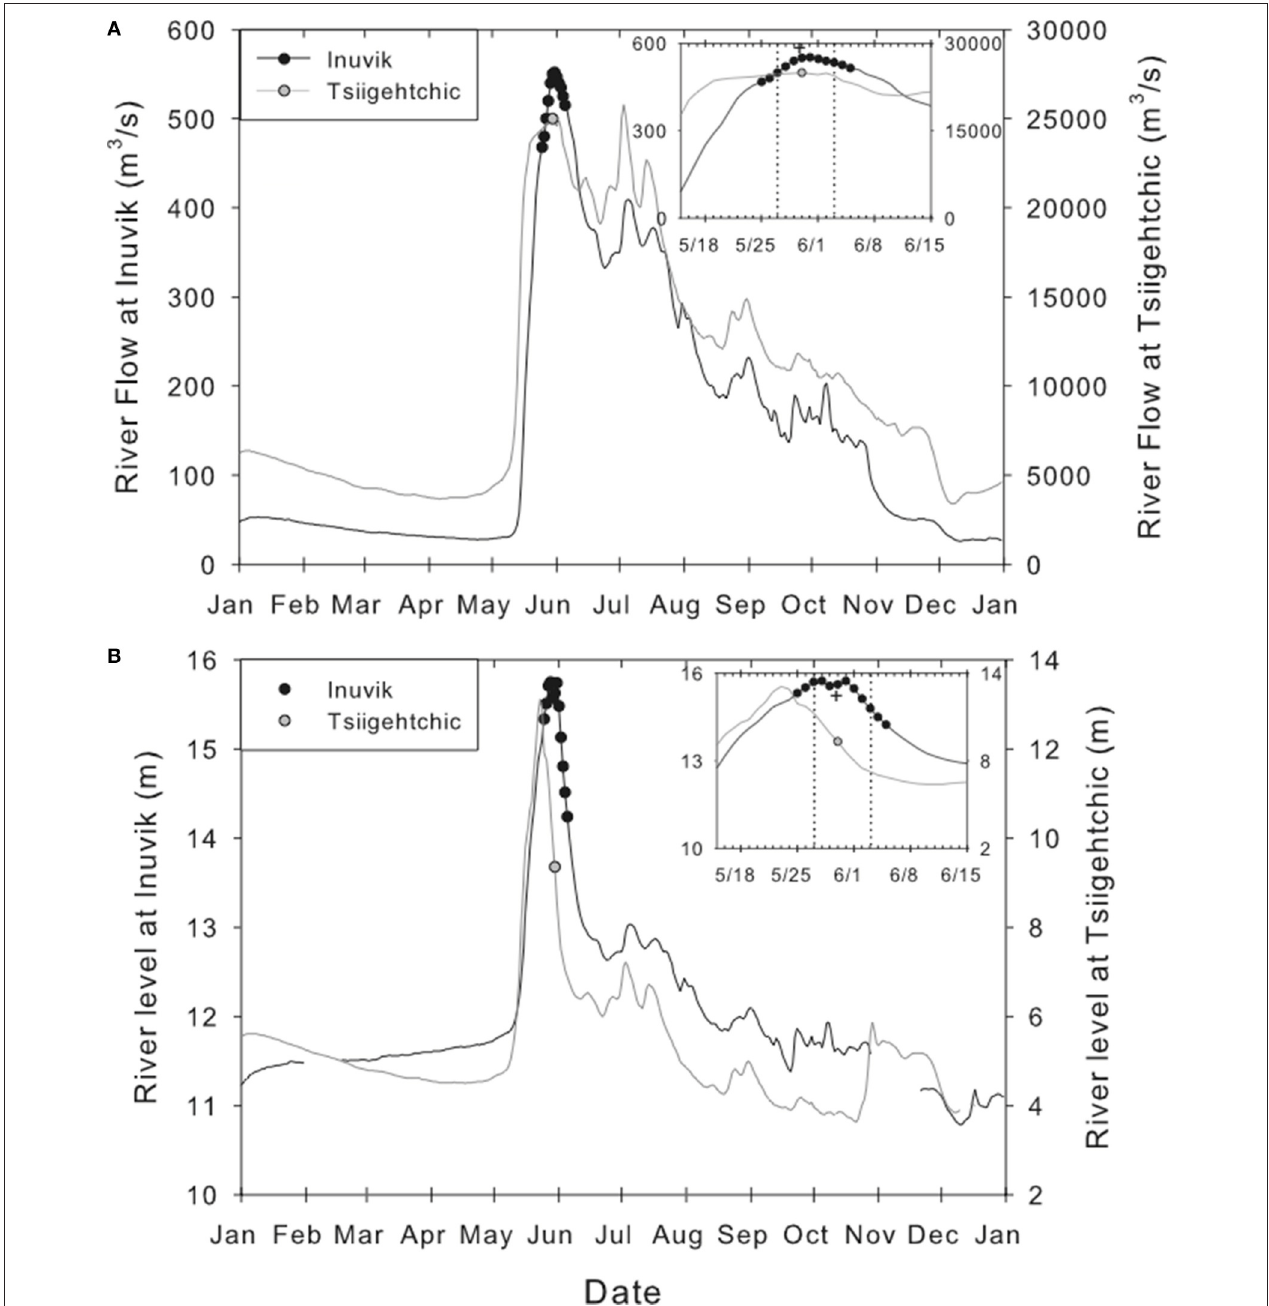
FIGURE 2 | Plots of (A) river flow and (B) river level at Inuvik (East Channel) and Tsiigehtchic (Main Channel) for the year 2008, with sampling dates shown as circles. The insets show expansions of the data from mid-May to mid-June. The two dashed lines indicate the day the ice broke up and flowed, and the day the river was ice-free at Inuvik, and the plus sign ( + ) marks the day we observed large amounts of coarse woody debris floating in the channel at Inuvik. Hydrographic data are from Environment Canada, Water Survey of Canada (http://wateroffice.ec.gc.ca).